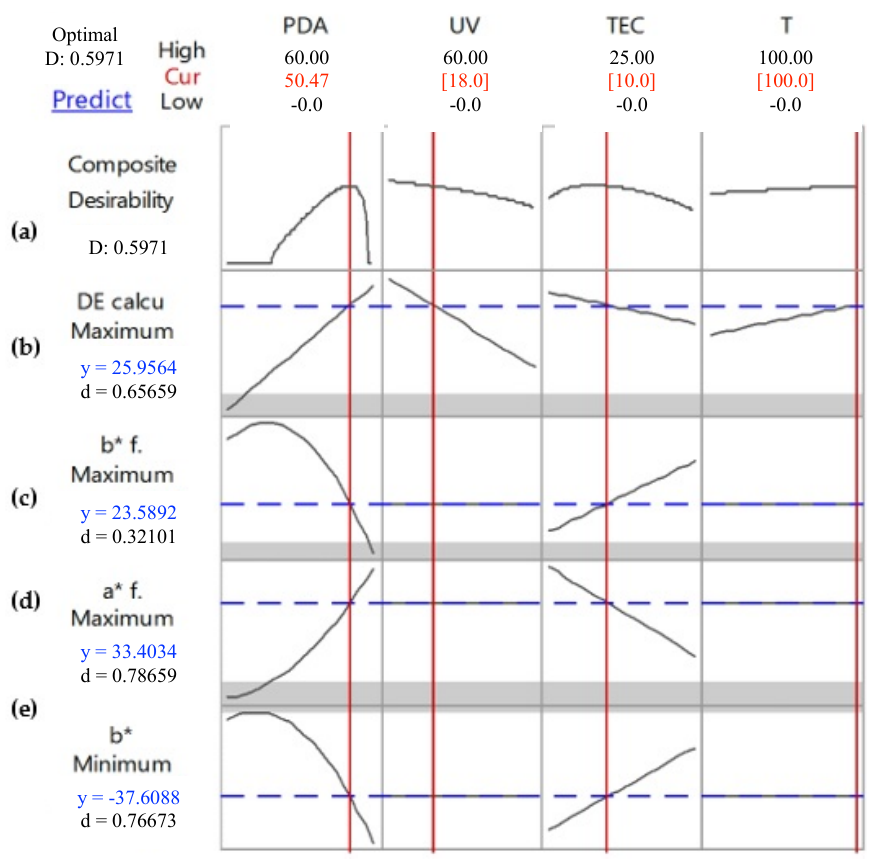
Figure 7. The optimized response of the intelligent films to maximize color transitioning, establishing the highest ΔE*, a * f and b* f values and the lowest b* value of the PDA films.